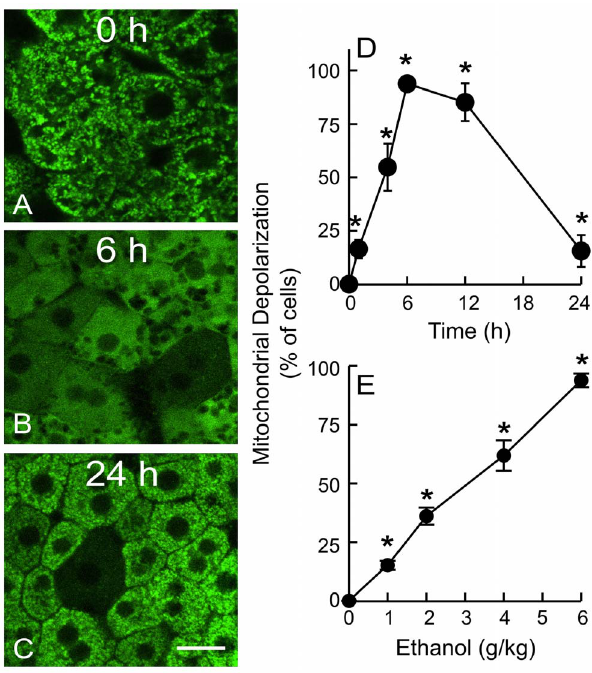
Figure 2. Ethanol causes reversible mitochondrial depolariza- tion in vivo in a dose-dependent manner. Mice were gavaged with one dose of ethanol (0–6 g/kg) in saline, and mitochondrial polarization was detected by intravital multiphoton microscopy of Rh123 at 0 to 24 h after treatment. Representative images from mice treated with 6 g/kg ethanol are shown in A – C . Bar is 10 m m. D : time course of mitochondrial depolarization after treatment with 6 g/kg ethanol; E : dose-dependency of mitochondrial depolarization at 6 h after ethanol treatment. Values are means 6 SEM (n=4–5 per group). *, p , 0.05 vs no ethanol.